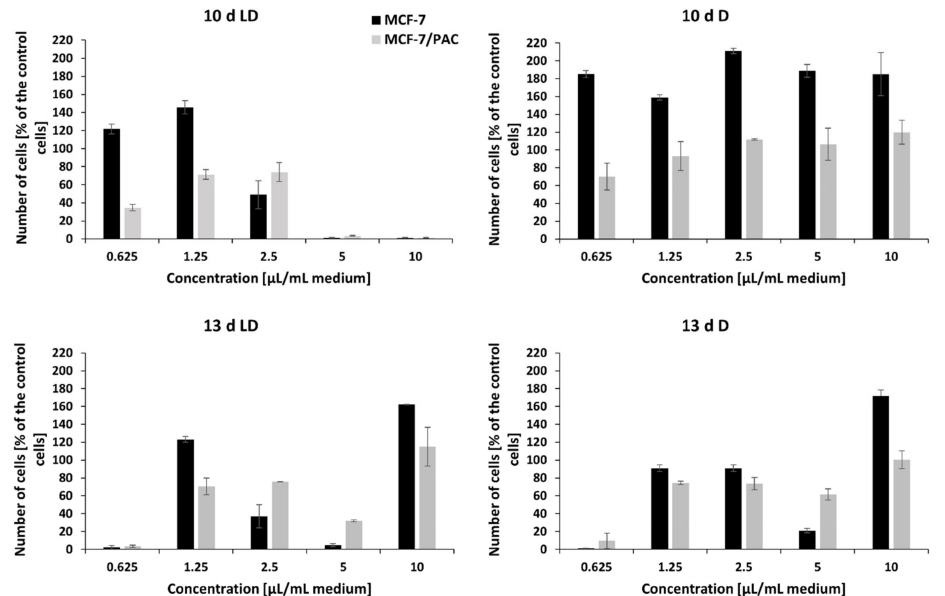
Figure 6. The effect of the crude extract of peptaibols on viability of human breast cancer cell line (MCF-7) and its multidrug- resistant subline (MCF-7/PAC), growing in monolayers. Tested peptaibol-containing extracts were obtained from a colony of T. atroviride O1 on the 10th or 13th day of cultivation (10 d, 13 d, d = day) in dark mode (D) or in a circadian rhythm (LD) on PDA agar; the amount of applied extract was 0.625, 1.25, 2.5, 5, and 10 µ L per 1 mL of cultivation medium (10 d LD = 5.5, 13.1, 21.9, 43.7, and 87.5 µ g/mL, respectively; 10 d D = 7.4, 17.8, 29.7, 59.4, and 118.8 µ g/mL, respectively; 13 d LD = 5.2, 12.6, 21.0, 41.9, and 83.8 µ g/mL, respectively; 13 d D = 6.8, 16.2, 27.0, 54.1, and 108.1 µ g/mL, respectively), and the time of exposure to compounds was 72 h.